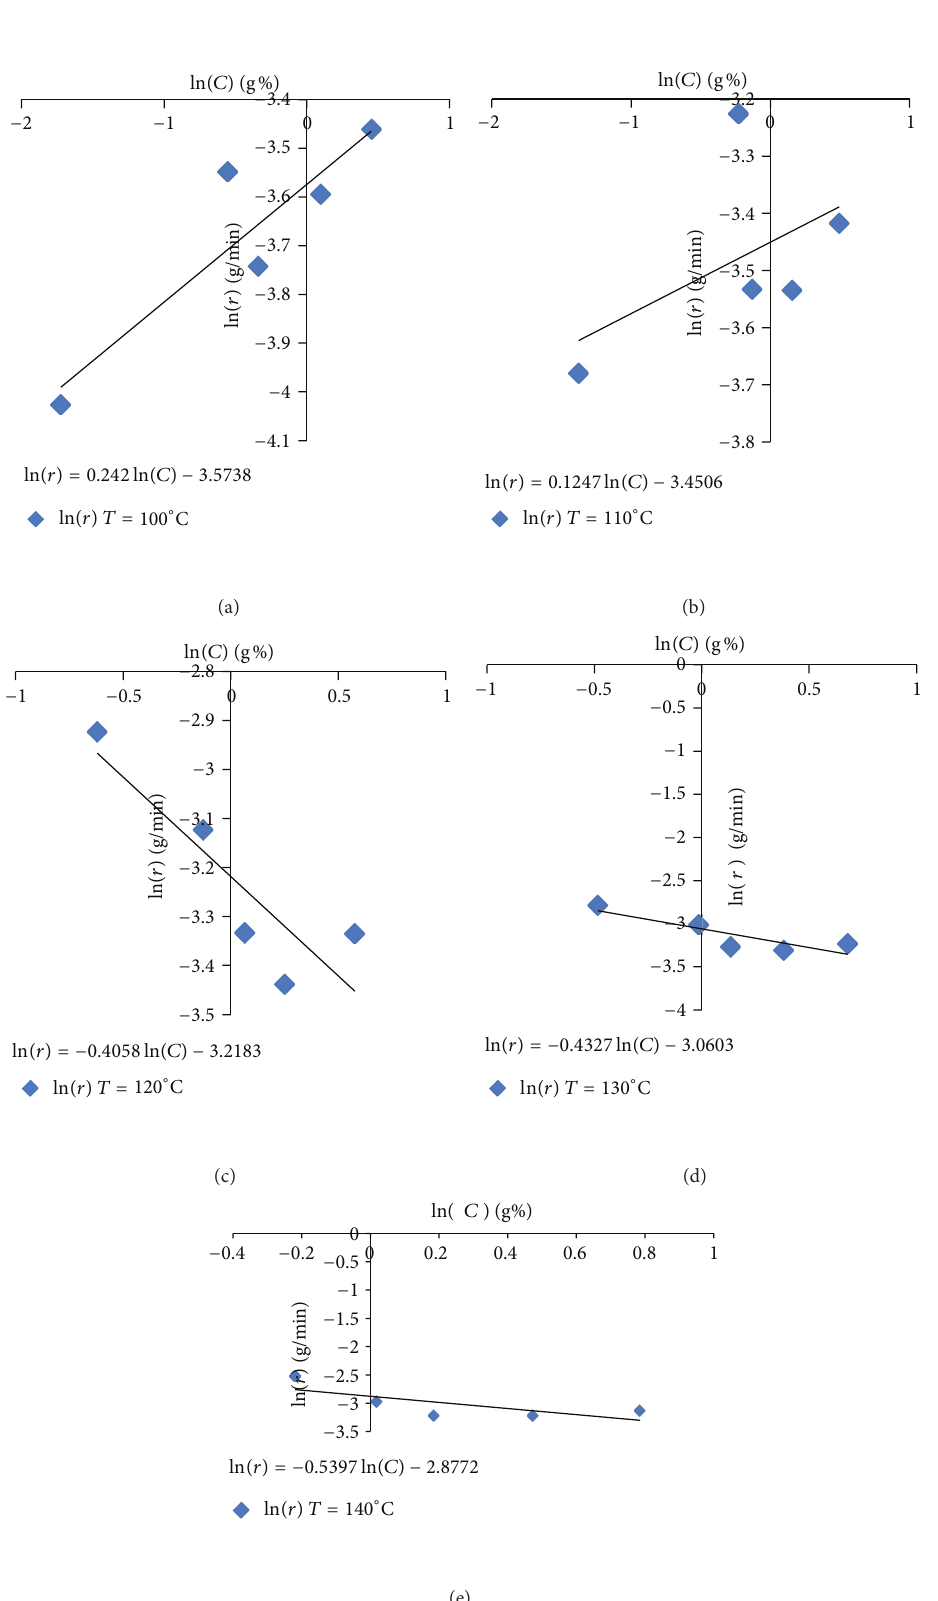
Figure 1: The ln (𝑟) versus ln (𝐶) of PVC resin at different times (min) and at different temperatures (100–140 ∘